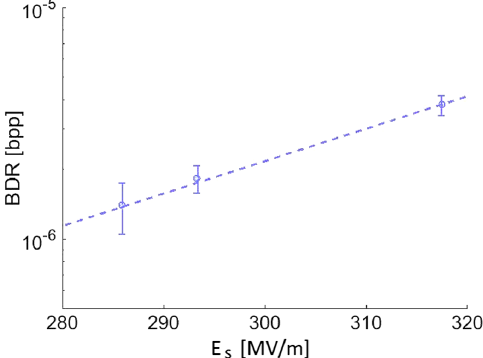
FIG. 9. Measurement of BDR as a function of peak surface electric field. The dashed line shows the power law fit E 10